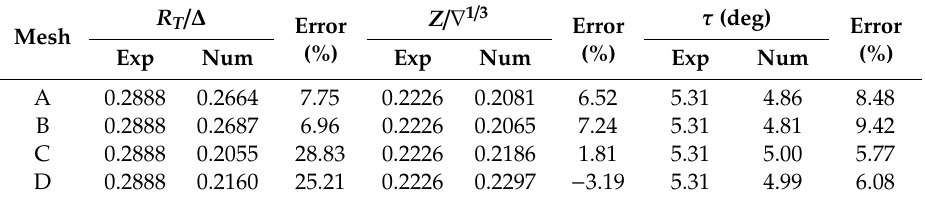
Table 5. Comparison of numerical and experimental values for each mesh scheme.